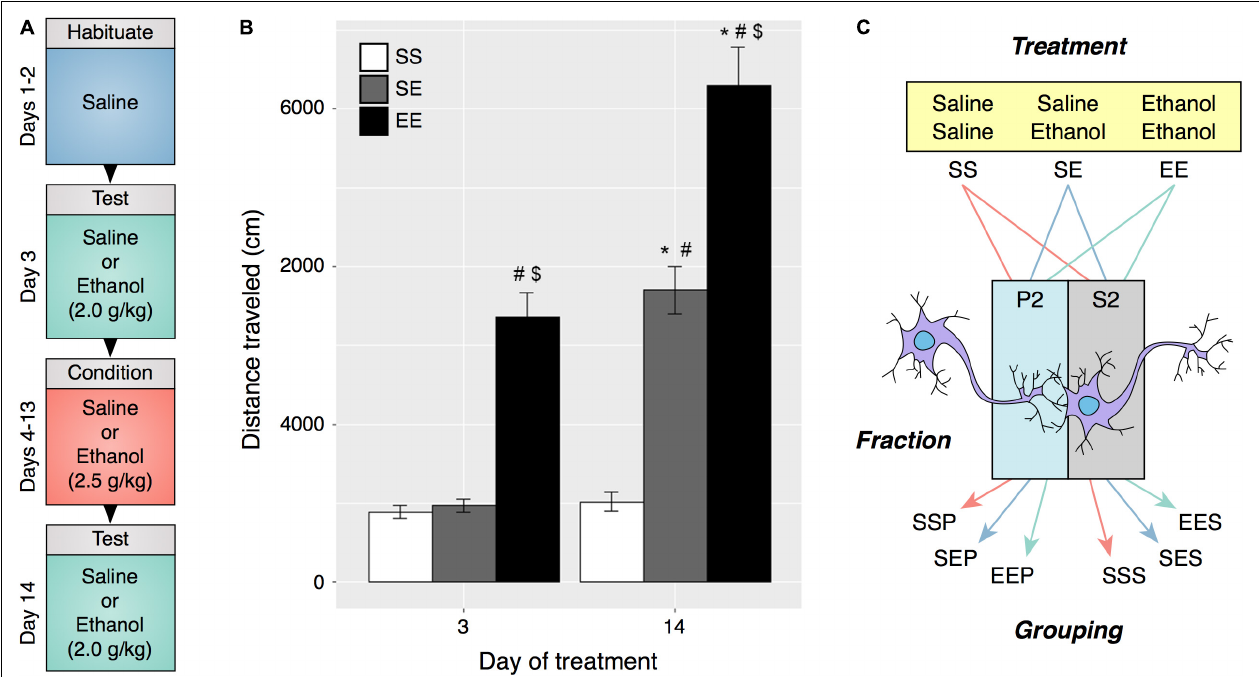
FIGURE 1 | Ethanol behavioral sensitization in male DBA2/J mice. (A) Experimental protocol and timeline for induction of behavioral sensitization. (B) Repeated ethanol exposure induced behavioral sensitization as measured by locomotor activity on day 14 (EE) as compared to acute ethanol administered on day 3 (EE) and day 14 (SE). (C) Experimental groupings used for RNA sequencing and bioinformatic analysis were derived from ethanol treatment type and specific cellular fraction. (# p < 0.001 compared to SS within same day, $ p < 0.001 compared to SE within same day, ∗ p < 0.001 compared to same treatment on day 3, repeated measures two-way ANOVA with Tukey’s post hoc